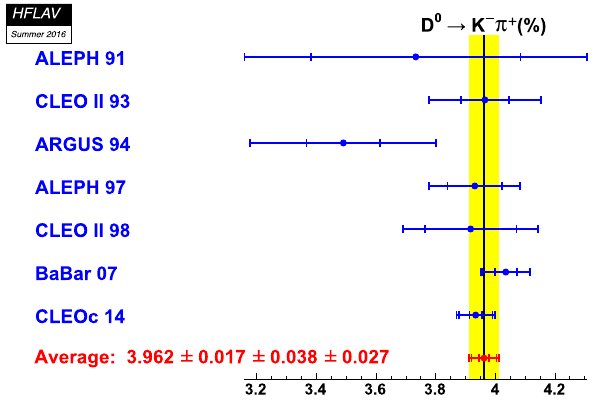
Fig. 211 Comparison of measurements of B ( D 0 → K − π + ) ( blue ) withtheaveragebranchingfractionobtainedhere( red ,and yellowband )